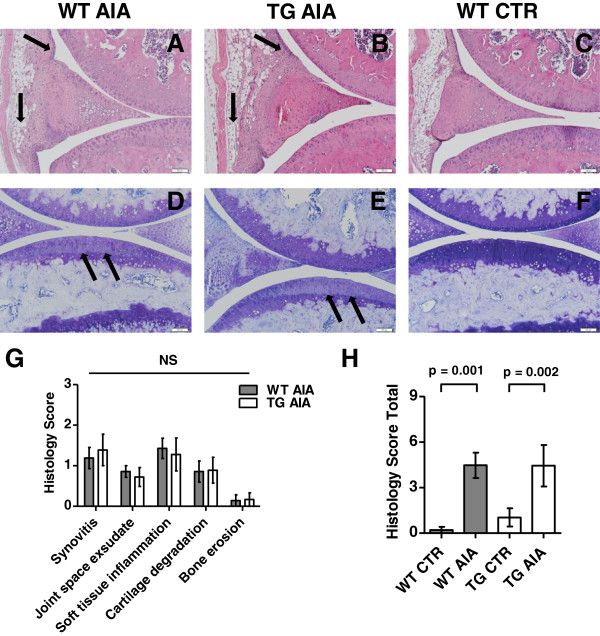
Arthritis and cartilage damage in the knee joint on day 28 of prolonged arthritis. Mice received intra-articular injection on day 0 and three repeated intravenous boosts with antigen or PBS on days 7, 14, 21. (A–F) Representative histologic sections of knee joints from wild-type (WT) and transgenic (TG) mice treated with mBSA (AIA) and from non-arthritic wild-type control mice (CTR). Both inflammatory activity and cartilage damage were similar in TG and WT mice. (A–C) Haematoxylin and eosin staining. Arrows show synovitis and soft tissue inflammation. Bars = 100 μm. (D–F) Toluidine blue staining. Arrows show proteoglycan loss of articular cartilage. Bars = 100 μm. (G-H) Histopathology scores (G single, H total) in mBSA treated mice (AIA) on day 28 post intra-articular injection and three flare-up reactions. The knee joints of all mice were assessed as described in Materials and Methods. Bars show the mean ± SEM. Findings in arthritic wild-type and transgenic mice for single scores were compared by Mann–Whitney test. Total scores were compared between the 4 groups with adjustment for 4 parallel tests (α* = 0.0125). NS = not significant.